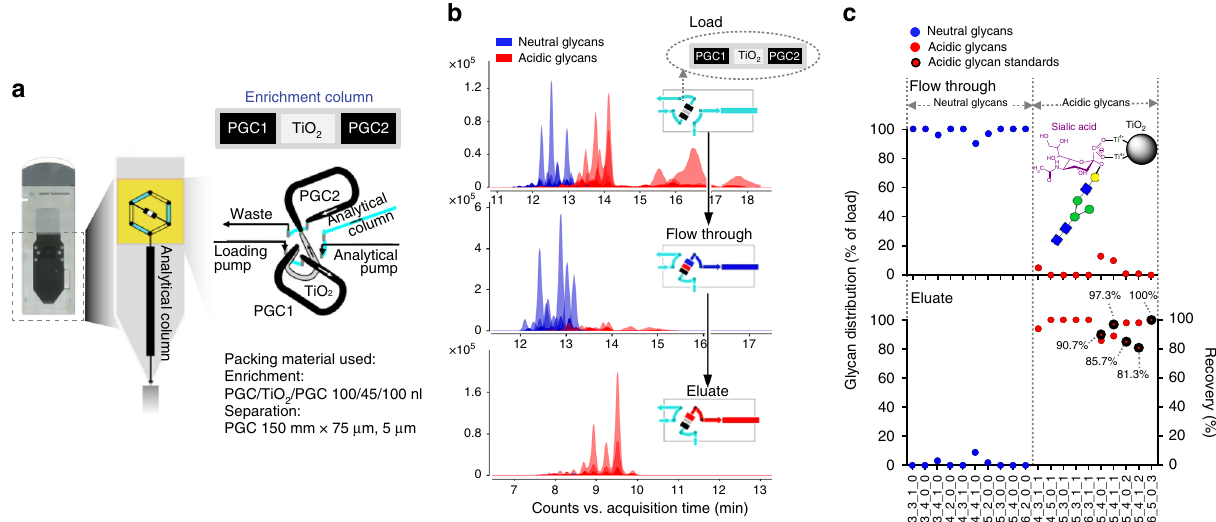
Fig. 1 On-chip enrichment of acidic N-glycans. a Diagram of the specialized TiO 2 -PGC chip. b Extracted compound chromatograms (ECC) of N-glycans detected in the load, fl ow-through (neutral N-glycans) and eluate fractions (acidic N-glycans) of the TiO 2 enrichment column as analyzed by liquid chromatography coupled with nanoelectrospray ionization quadrupole time-of- fl ight mass spectrometry in the positive mode. c TiO 2 enrichment column selectively captures acidic N-glycans. Neutral N-glycans ( blue dot ) do not ef fi ciently bind to TiO 2 and are recovered in the fl ow-through fraction, whereas acidic N-glycans are retained on TiO 2 during the load and fl ow-through steps and are eluted with the elution buffer. The enrichment recovery rates ( numbers beside the dots ) of fi ve acidic N-glycan standards ( red dots with black circles ) are also